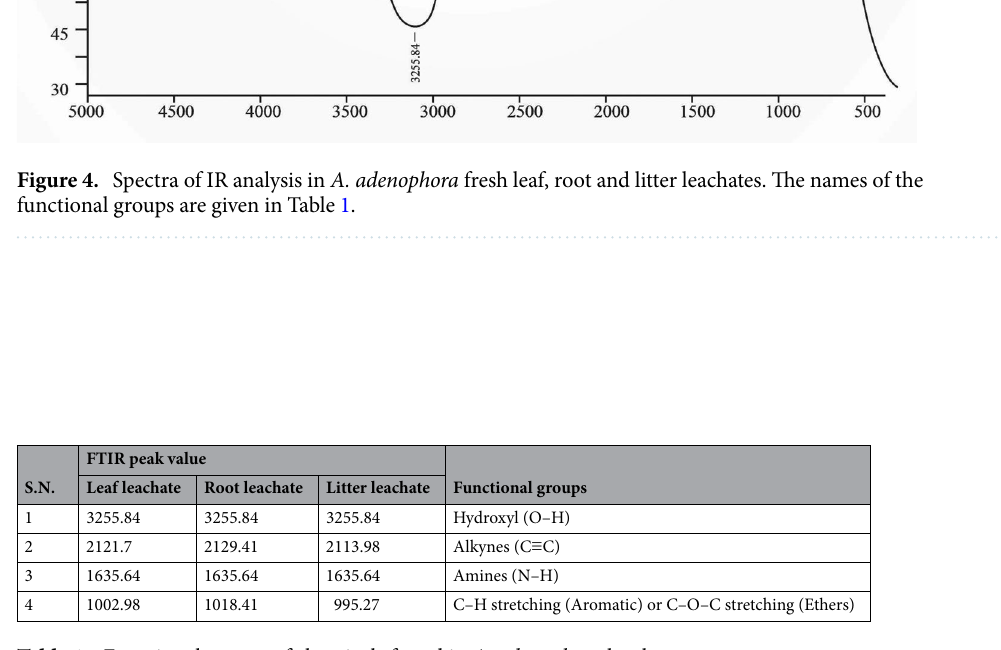
Table 1. Functional groups of chemicals found in A. adenophora leachates.